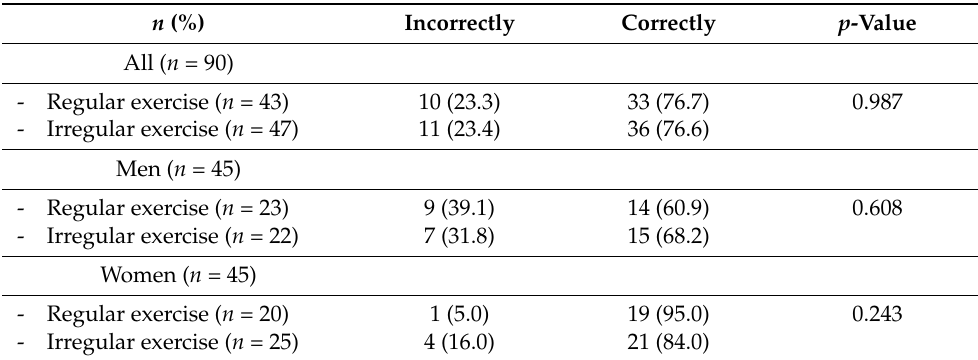
Table 5. Percentage distribution (%) self-classified weight group (divided into correctly or incor- rectly *) at startup of fitness club membership and regular fitness club attendance ( ≥ 2/week) at three months